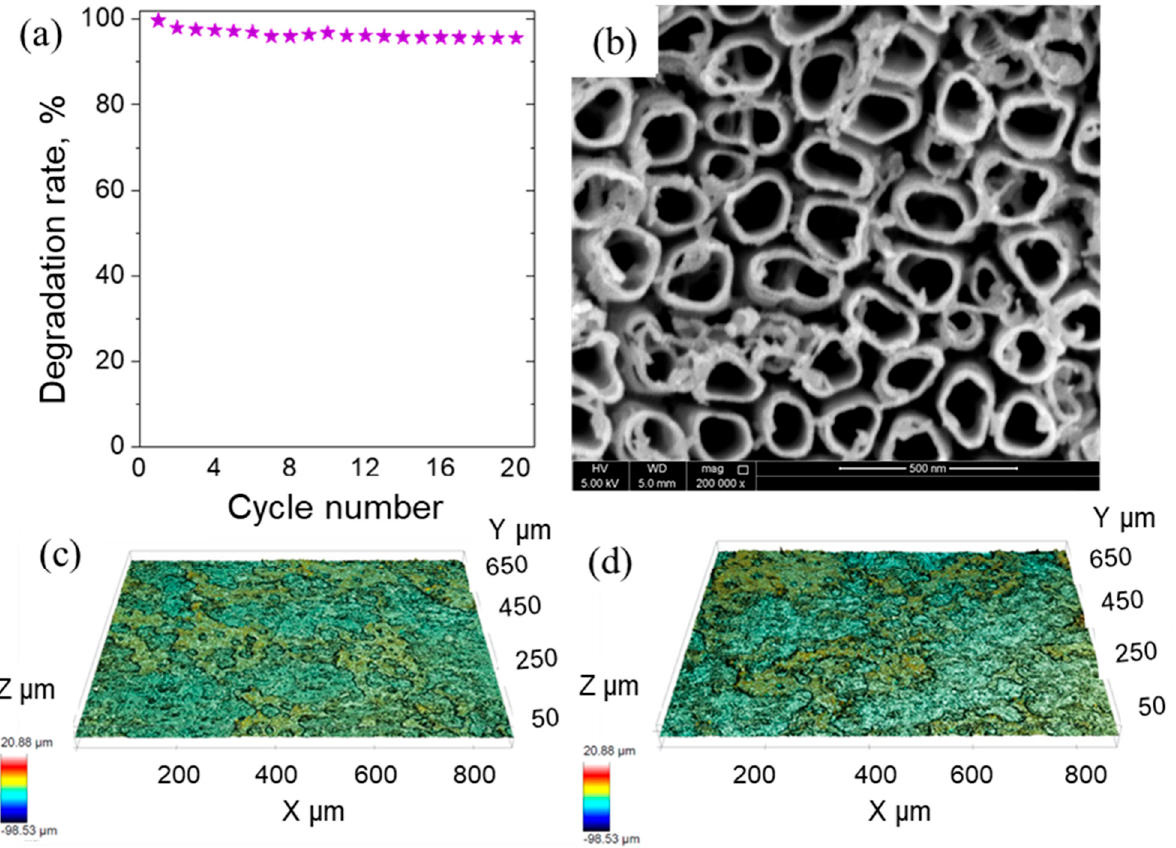
Figure 6. ( a ) MO degradation (%) over 20 cycles. ( b ) SEM image of the TNA film at 500 nm scale bar after 20 cycles of operation. Comparison of surface topography of the annTNA film ( c ) before and ( d ) after use in the MO degradation test: Color codes in ( c ) and ( d ) indicate depth relative to the ground plane.